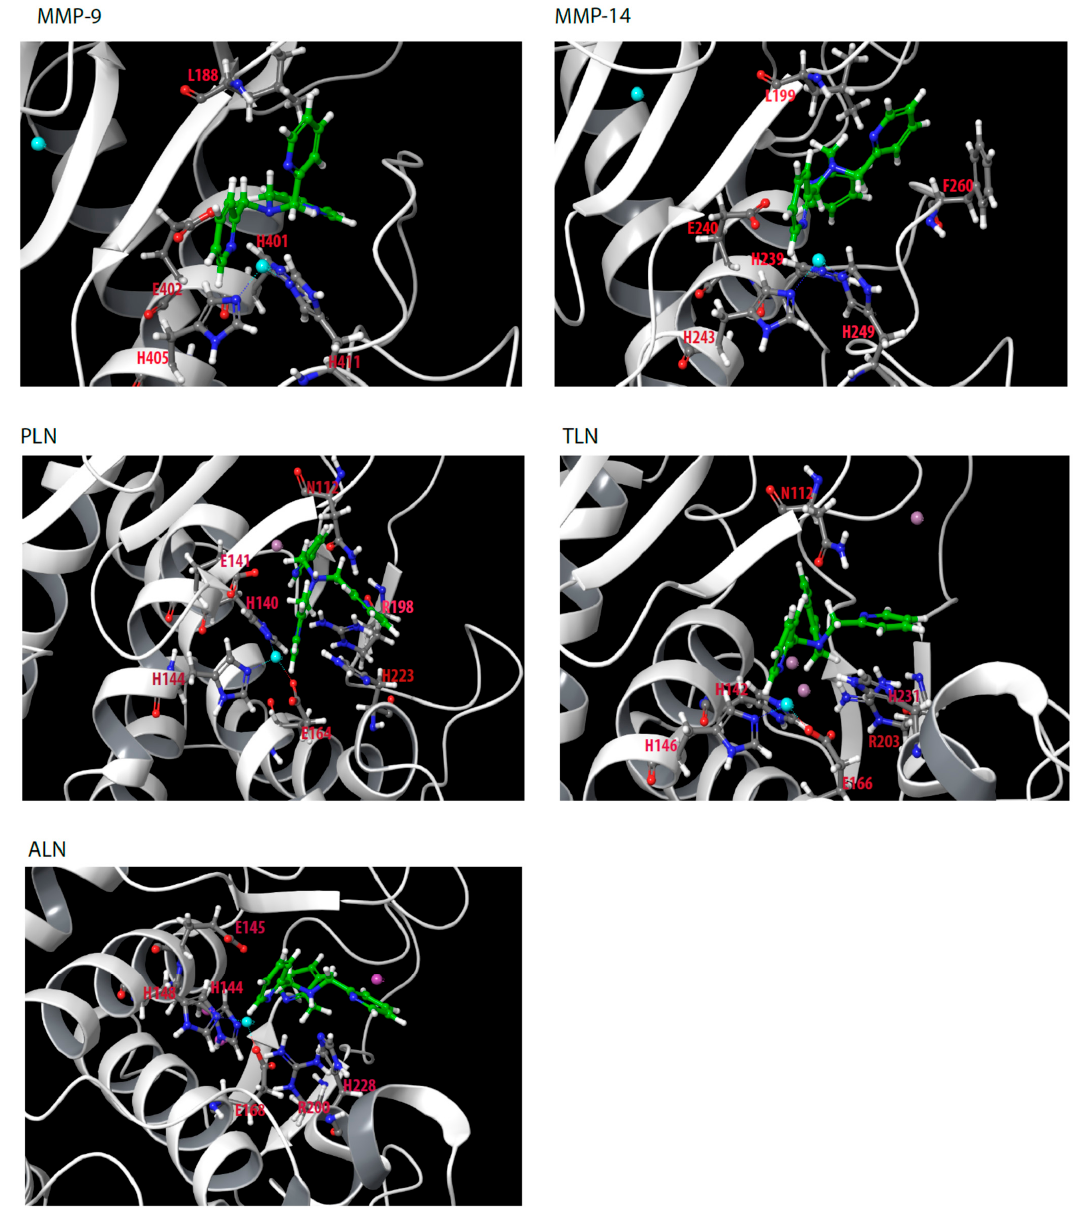
Figure 5. TPA docked into the catalytic site of MMP-9, MMP-14, PLN, TLN and ALN. Some of the most important amino acids for TPA binding are shown. Color coding of amino acids: carbon; grey, oxygen; red, nitrogen; dark blue, hydrogen; white. Color coding of TPA: carbon; green, nitrogen; blue, hydrogen; white Color coding of ions: zinc; light blue sphere, calcium; pink sphere.